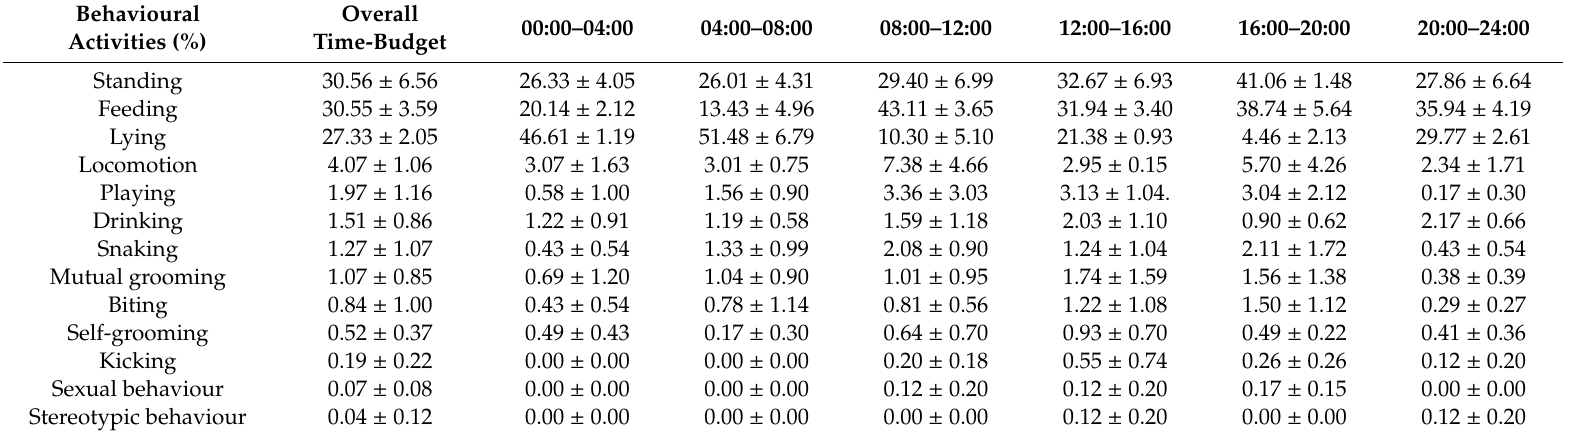
Table 4. Overall time-budget and time frames of di ff erent behavioural activities performed by horses reared for meat production. Frequencies (%) of behavioural activities are expressed as means ±